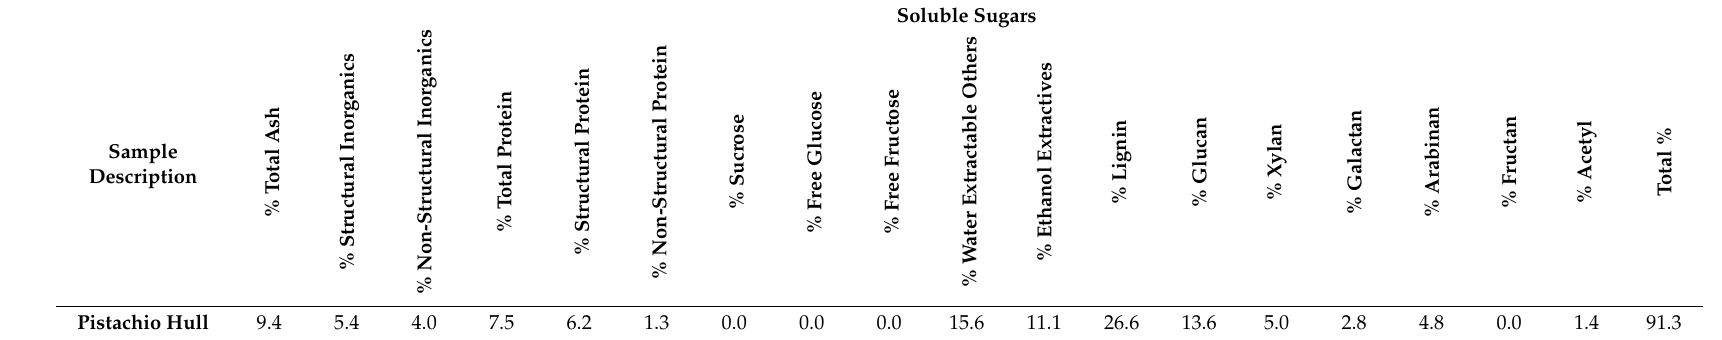
Table A1. Analysis of pistachio hulls used in this